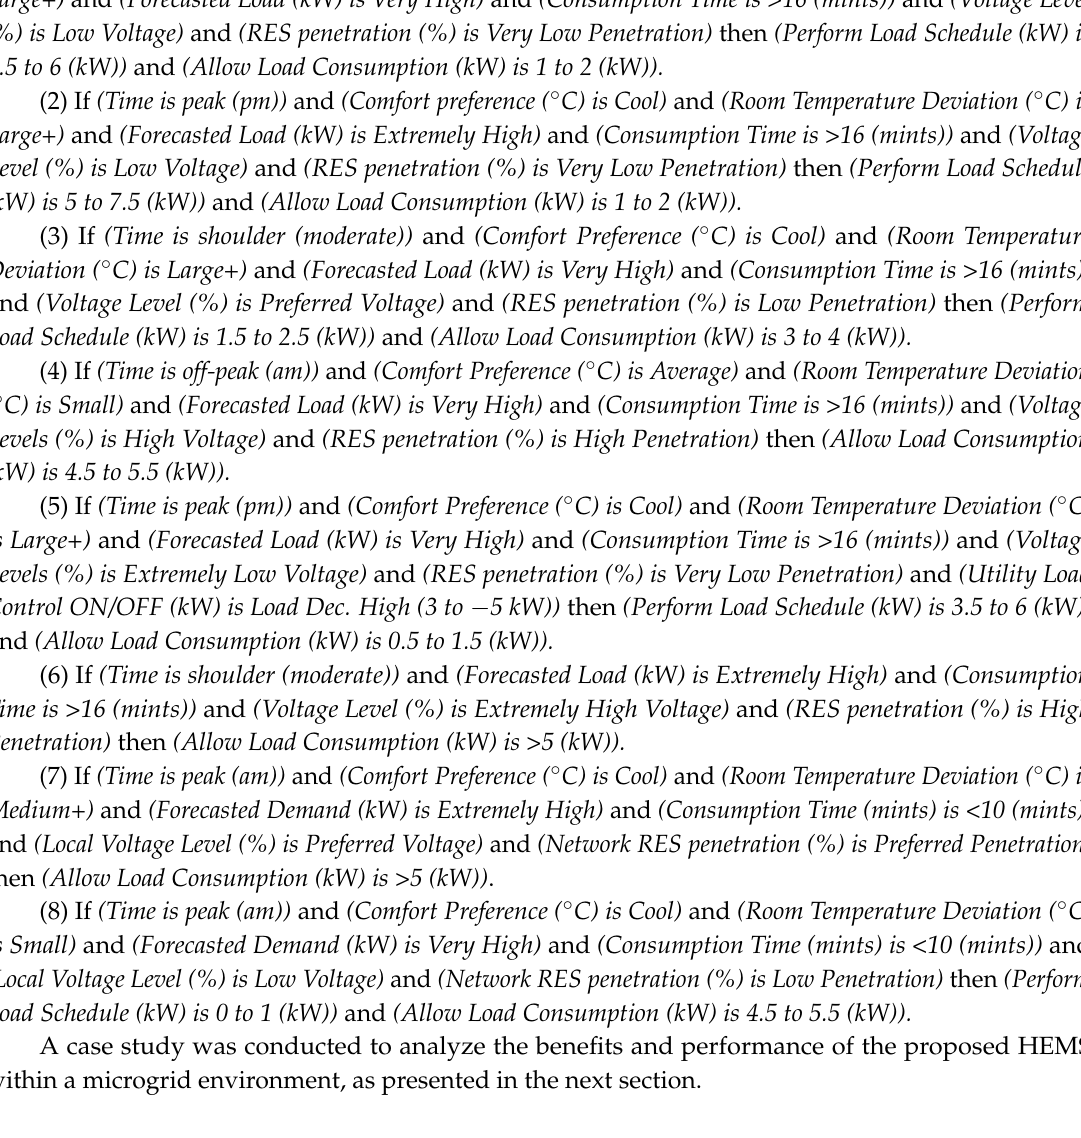
Figure 12. Fuzzy output membership function for ( a ) perform load schedule and ( b ) allow load Figure consumption.